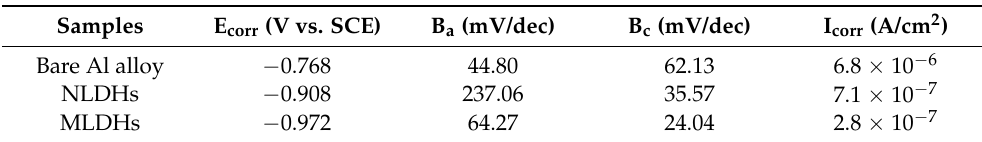
Figure 3. Polarization curves of the bare alloy, NLDHs, MLDHs ( a ), and MLDHs immersion for a different time ( b ) in 3.5 wt.% NaCl solution. Table 1. Polarization parameters of the Al alloy substrate, NLDHs, and MLDHs in 3.5 wt.% NaCl